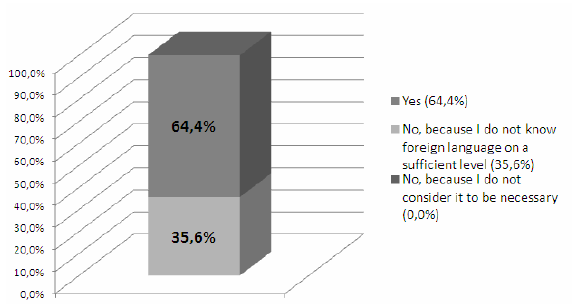
Figure 6. The results of the student survey in the possibility to study some courses at the Latvia University of Agriculture together with for- eign students in a foreign